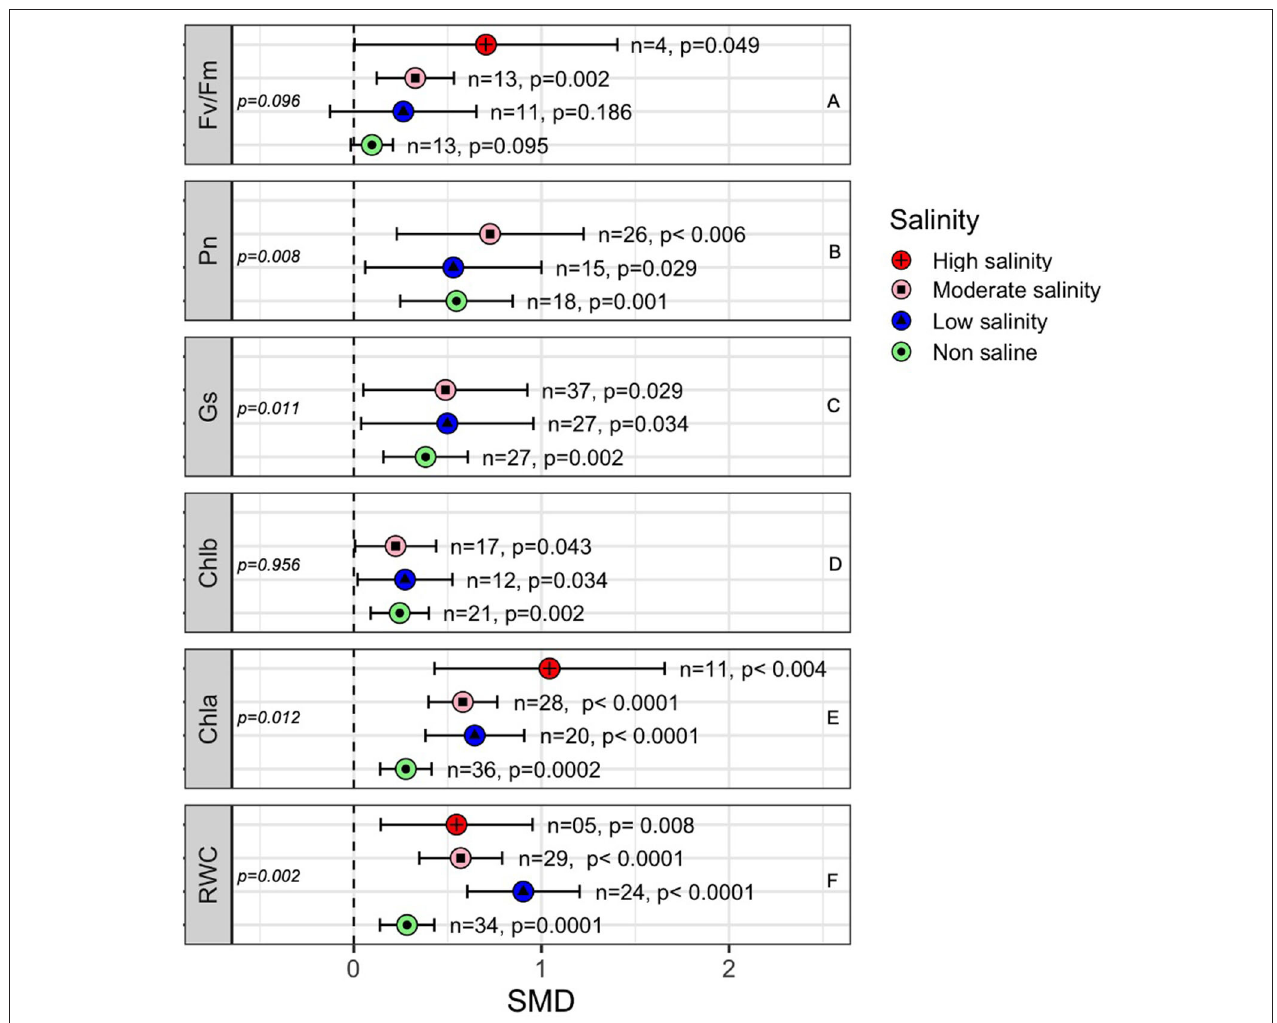
FIGURE 7 | Effects of mycorrhizae on plant photosynthetic parameters under different levels of salinity stress. Error bars are the effect size means the CIs do not overlap the vertical dashed lines, the effect size for a parameter is significant. n , number of studies included in the meta-analysis. Chla, Chlorophyll a; Chlb, Chlorophyll b; Fv/Fm, maximal photochemical efficiency; Gs, Stomatal conductance; Pn, rate of photosynthesis; and RWC, Relative water content; n , number of studies included in the meta-analysis; p , significance level of